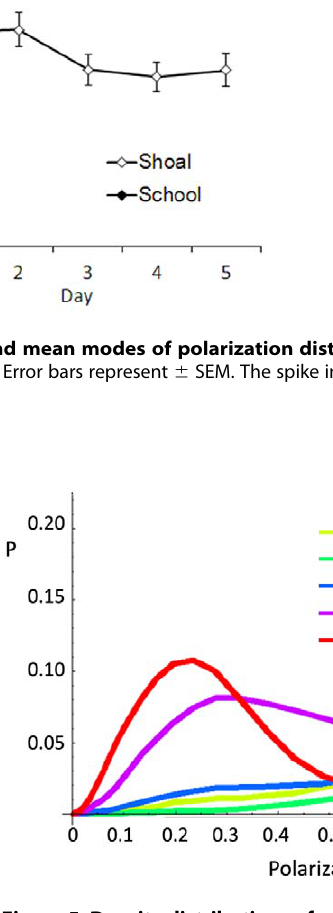
Figure 5. Density distributions of polarization by group size for Experiment 3. Summed polarization distributions for each group size (N=5, 10, 20, 30, and 50). Distributions are averaged across the entire session (1800 frames per session) and all groups (4 groups of each size). Larger groups are significantly less polarized than smaller groups (K-S test, all p , 0.0001; see Table S3).